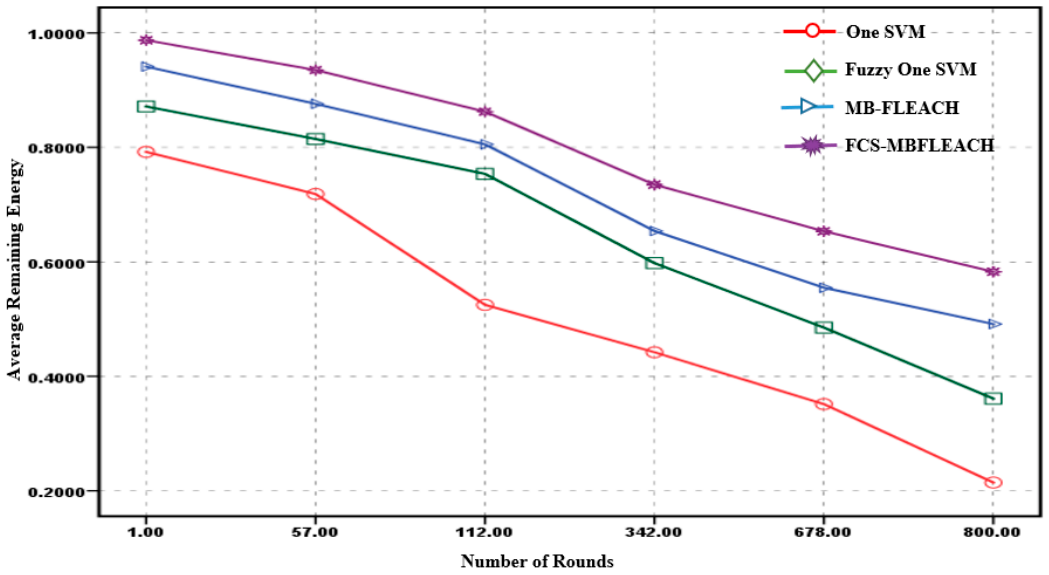
Figure 15. Average remaining energy for fault detection methods in different rounds for the first scenario.